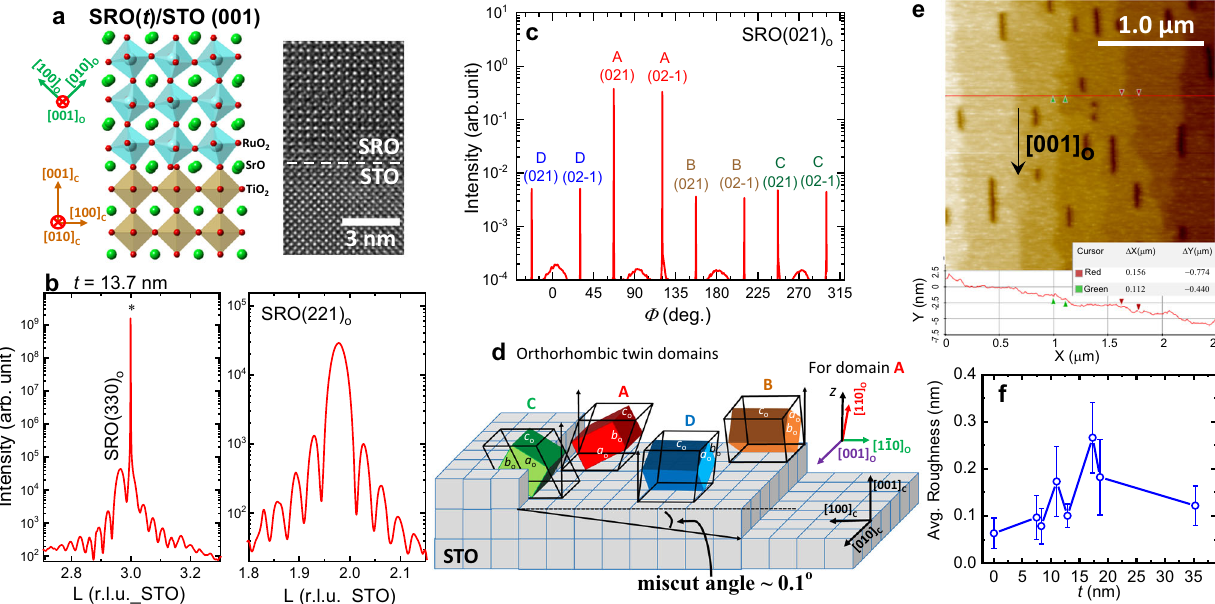
Fig. 1 Structural and surface characterizations of an untwinned SRO fi lm with t ≈ 13.7 nm. a An atomic packing illustration (left) and the cross-sectional STEM HAADF image (right) of (110) o oriented orthorhombic SRO on an STO (001) substrate. The left panel and right panel of b show the CTRs of SRO specular (330) o and off-normal (221) o re fl ections, respectively. Pronounced fringes persisting over many periods along both CTRs manifest the excellent crystallinity and sharp interfaces of the SRO fi lm. c The azimuthal ϕ scan across SRO (021) o re fl ection reveals the presence of four orthorhombic twin domains rotated 90 o from each other as demonstrated in d (not to scale). The dominant domain A, amounting to 94.1% of volume fraction, has its [001] o direction parallel to the atomic step edges on the STO surface as veri fi ed by XRD results as well as the AFM image in e , where the lower panel of e shows the fl attened cross-sectional height pro fi le along the red line. The c -axis of SRO lies on the surface and is aligned with one of the STO lateral crystalline axes, [010] c in the present fi gure. f The thickness dependence of the averaged surface roughness for SRO fi lms from AFM images analyses with uncertainties from the full width at half maximum in height histograms of AFM images. The averaged roughness is <0.3 nm, which does not vary signi fi cantly for t ≤ 35.3